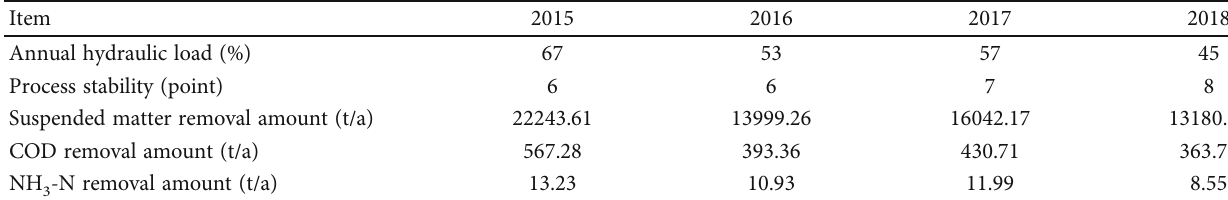
Table 11: Technical performance index